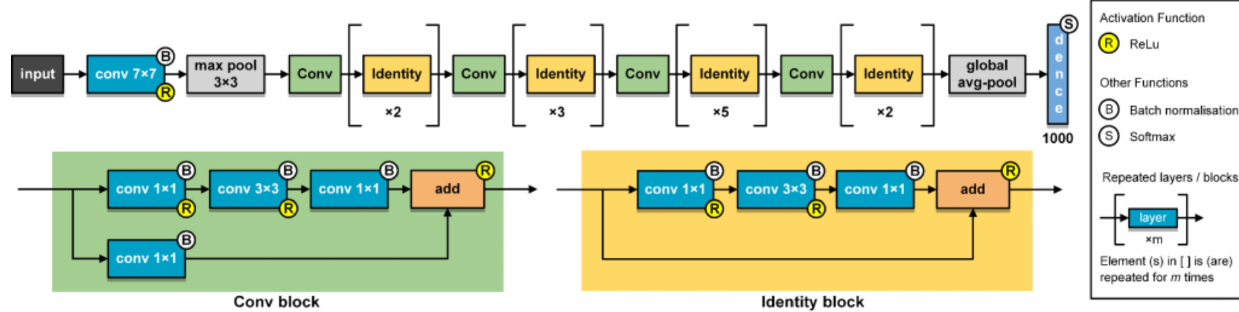
Figure 9. Detailed structure of the ResNet-50 feature extractor (adopted in Net-IV, Net-V, and